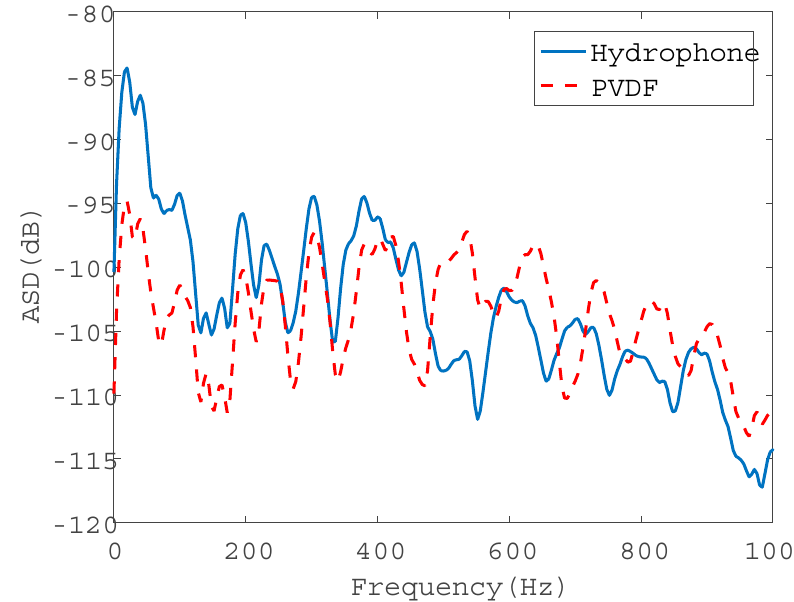
Figure 14. ASDs of the leak noise signals collected by the PVDF wire sensors of 6t and hydrophone at 0.9 m (in-water case).